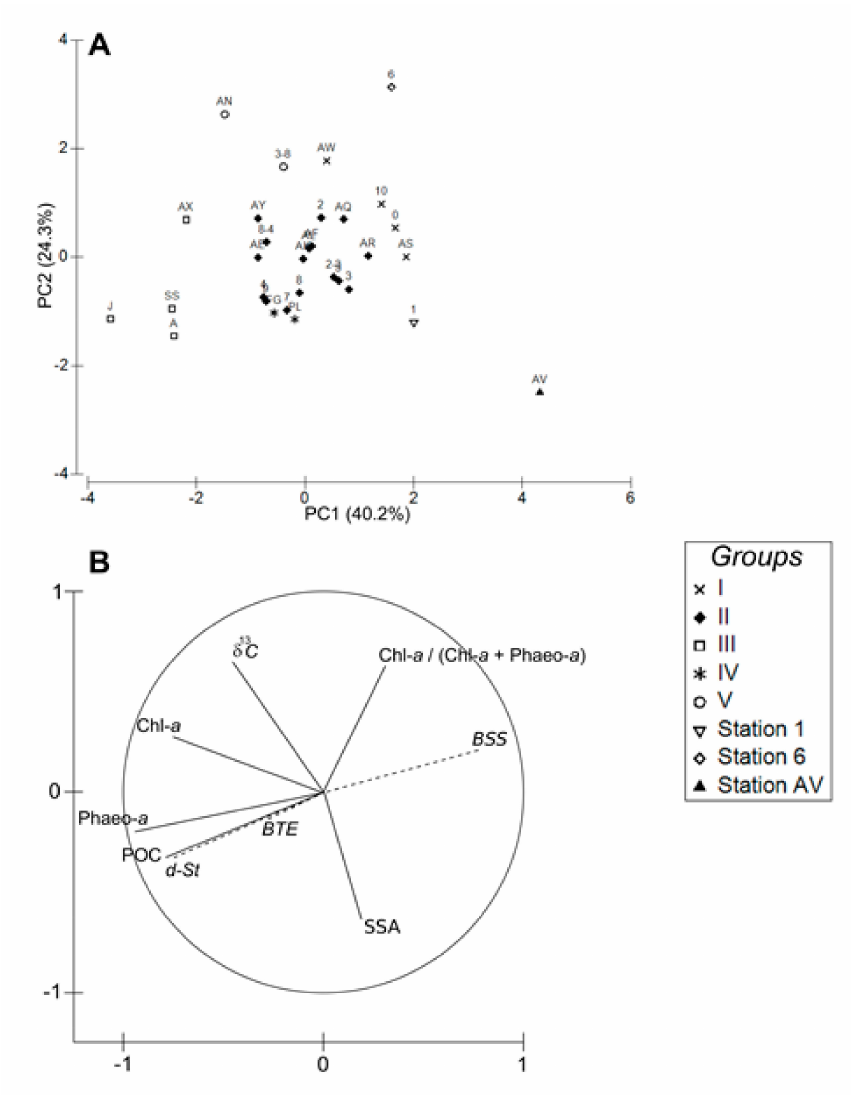
Figure 4. Principal component analysis based on normalized surface sediment characteristics (Sedi- ment Surface Area (SSA), POC, Chl- a , Phaeo- a , Chl- a /(Chl- a +Phaeo- a ) ratio and δ 13 C). Projection of stations on the first plane of the Principal Components Analysis (PCA) ( A ) and correlations of the variables with the first two components ( B ). Station depth ( d-St ), Bottom Shear Stress ( BSS ) and Bottom Trawling Effort ( BTE ) were used as supplementary variables. Group identification was achieved through the coupling of hierarchical clustering with a SIMilarity PROFile (SIMPROF) procedure. Station codes are the same as in Figure 1 and Table